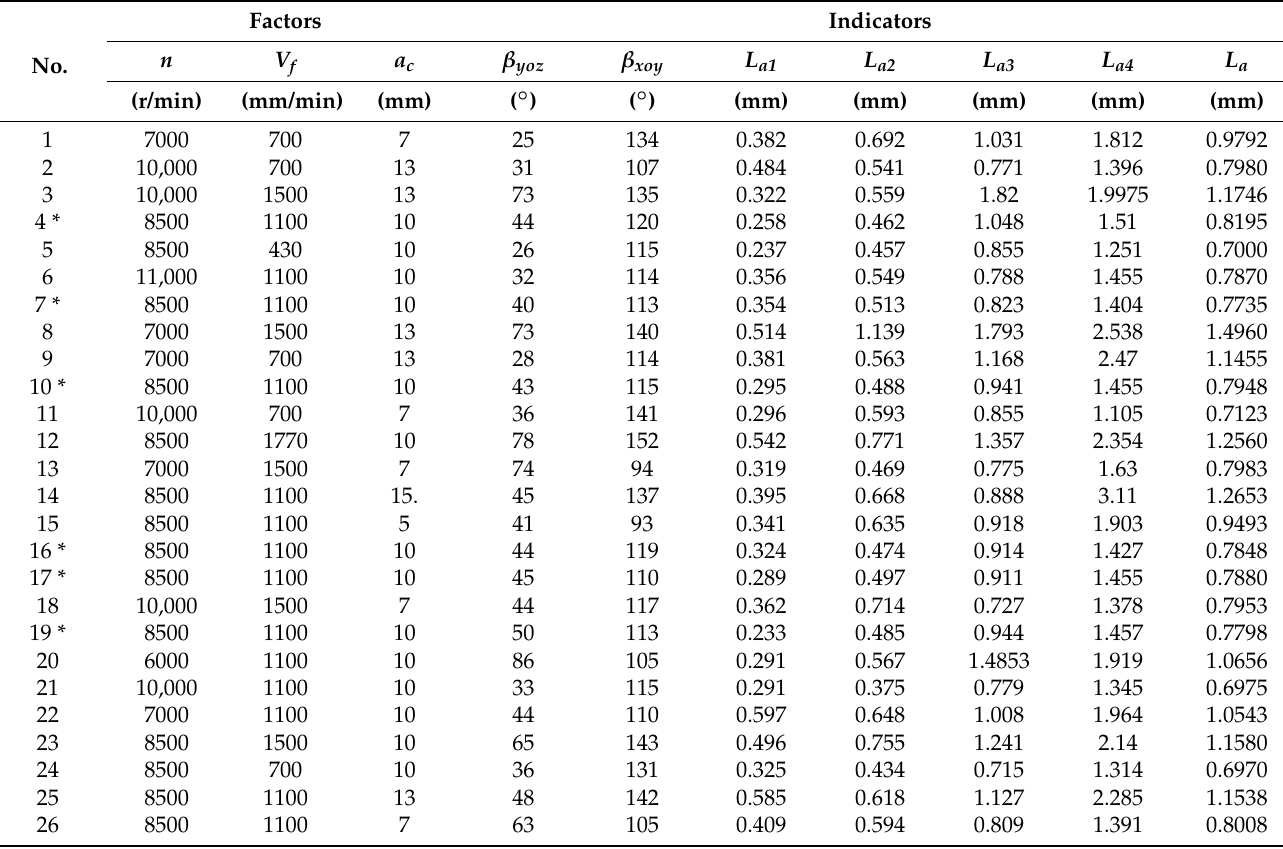
Table 3. CCD test results and supplementary test results.